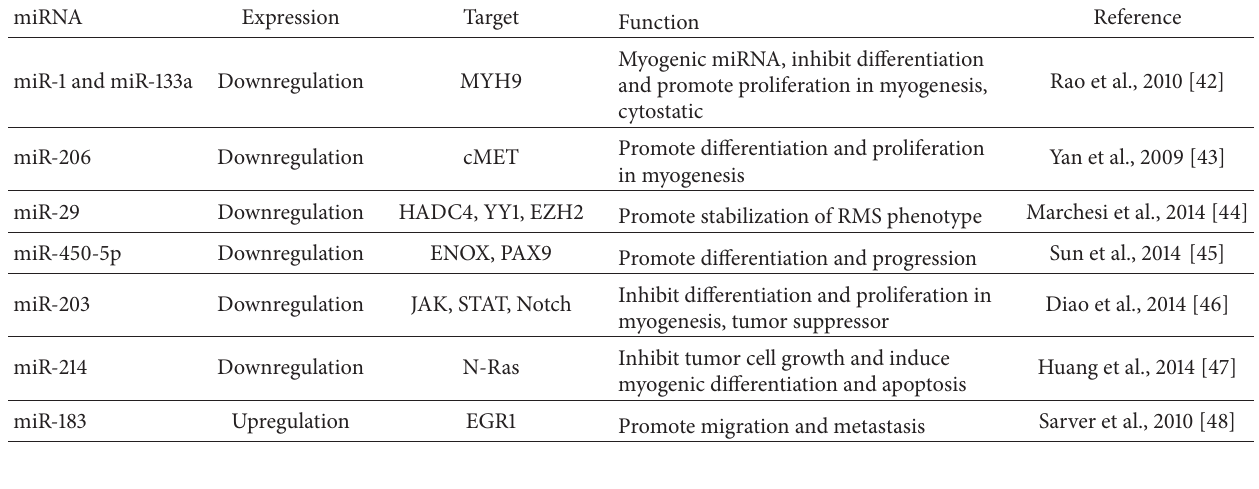
Table 4: MicroRNAs involved in myogenesis and RMS development.